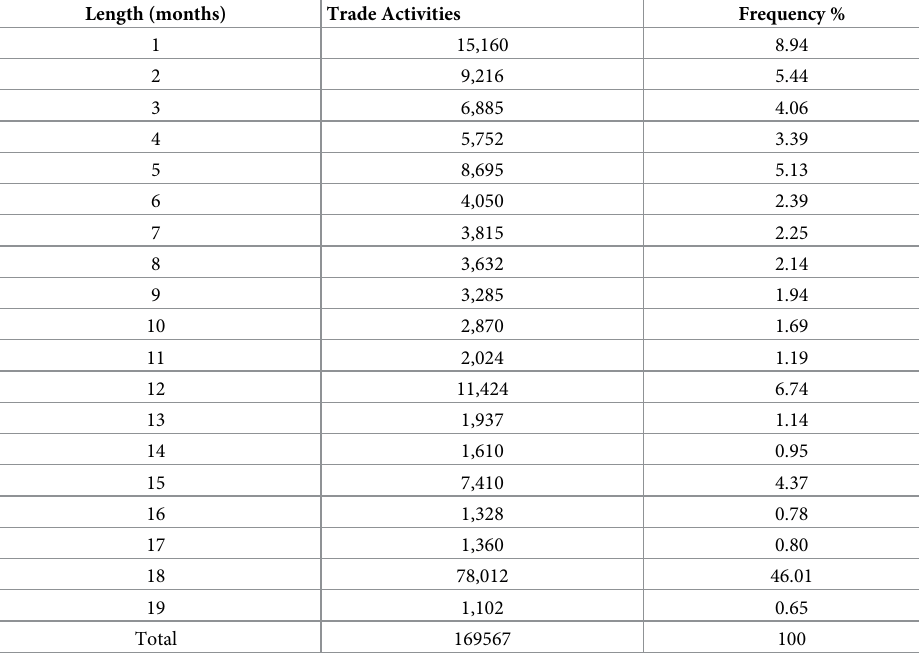
Table 1. Length of trade relationship (Source: Authors’